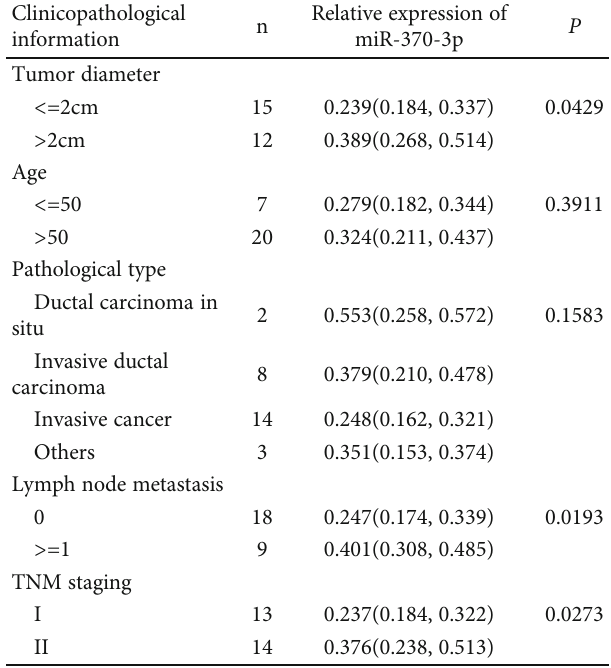
Table 4: The relationship between miR-370-3p in exosomes of breast cancer serum and clinicopathological